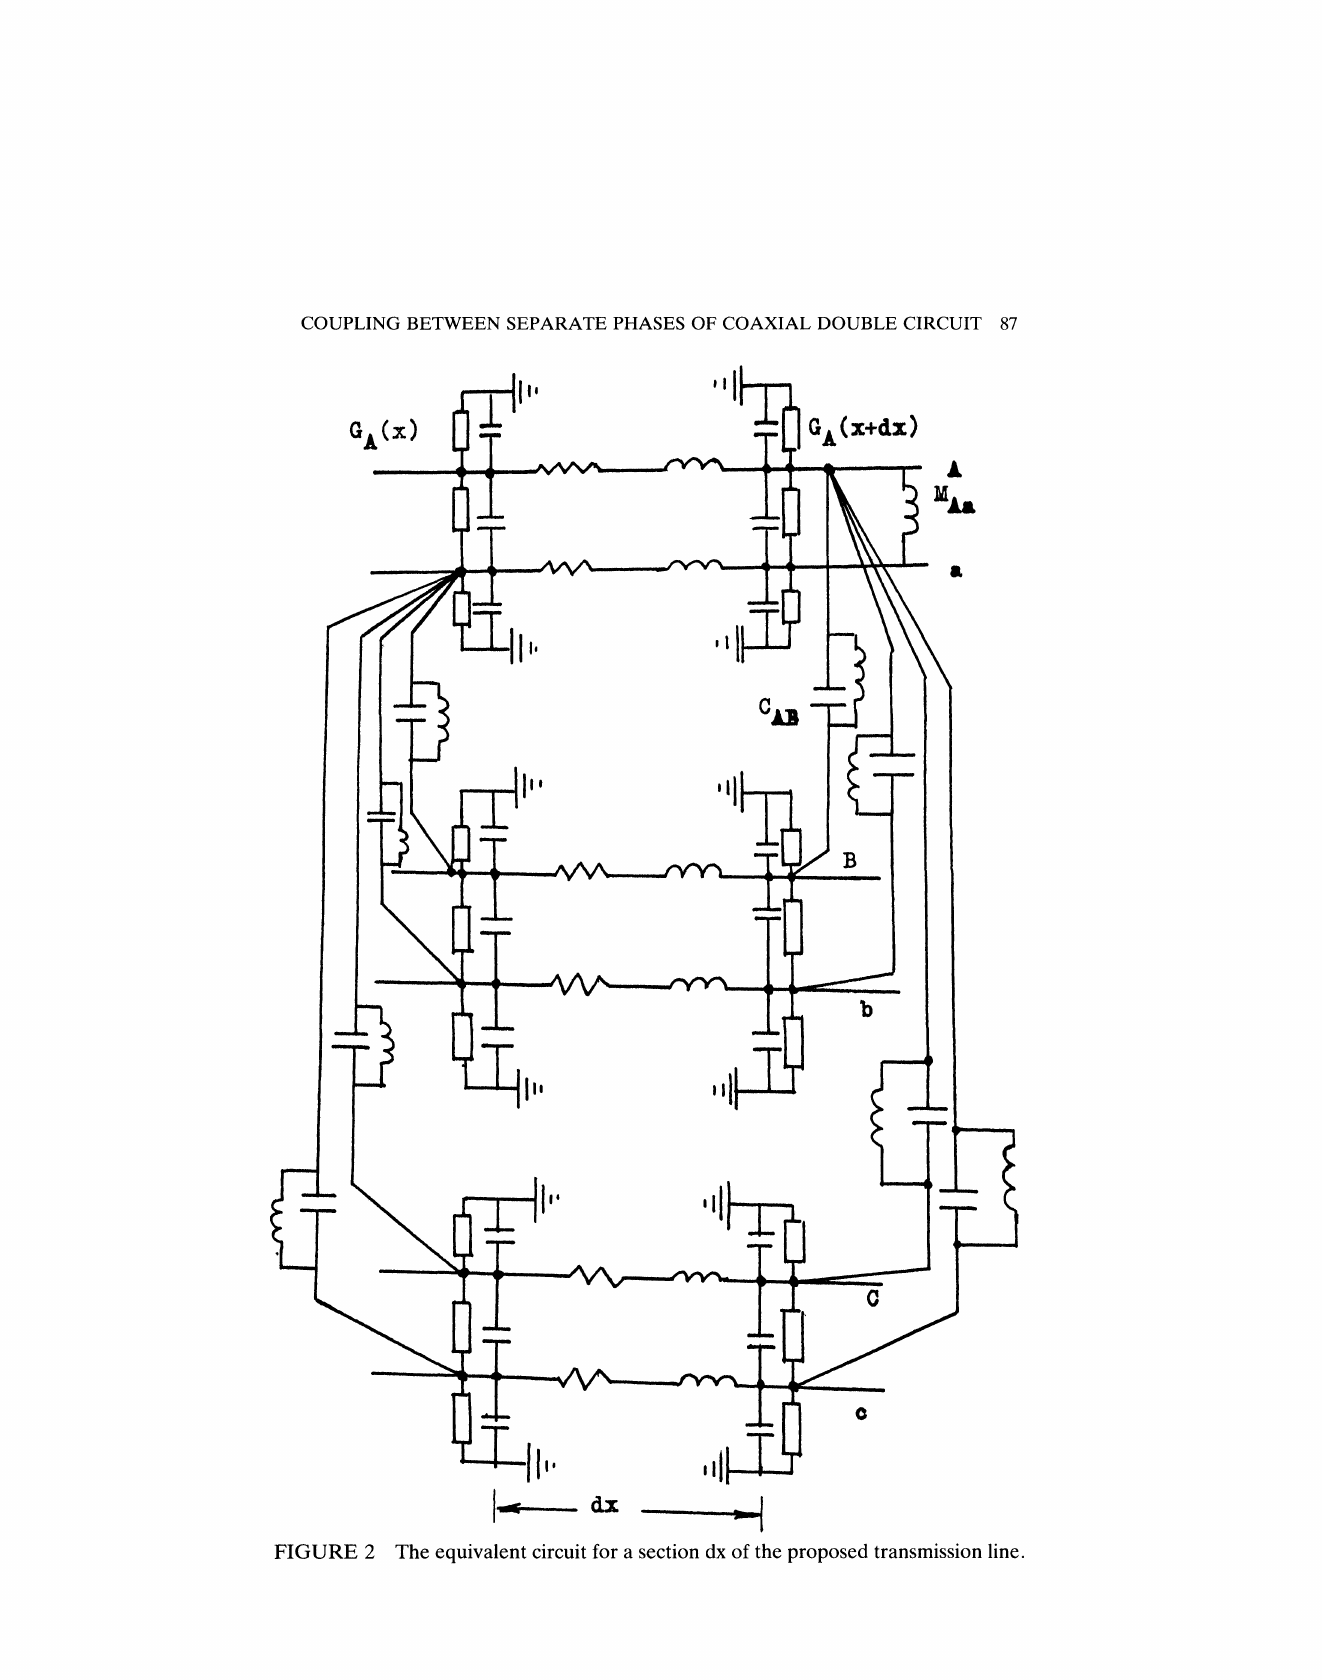
FIGURE 2 The equivalent circuit for a section dx of the proposed transmission